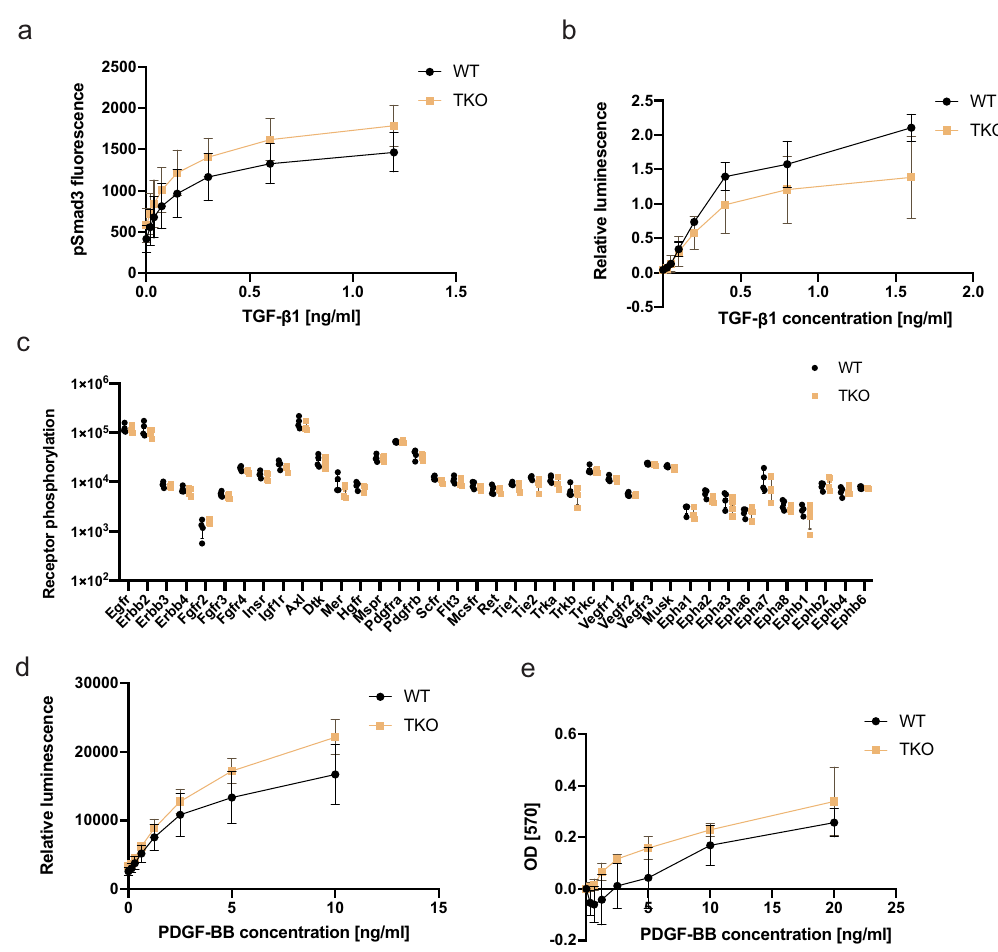
Fig. 5 TGF- β and RTK signaling appear unaltered in Lrig -null MEFs. a Wild-type (WT) and Lrig -null (TKO) MEFs were stimulated with various concentrations of TGF- β 1 for one hour and then analyzed for nuclear phospho-Smad3 (pSmad3) by an immunocyto fl uorescence assay. b Wild-type and Lrig -null MEFs were transiently transfected with the TGF- β reporter plasmid p(CAGA) 12 MLP-Luc followed by treatment of the cells with the indicated concentrations of TGF- β 1 for three hours. Cell lysates were then analyzed for luciferase activity. Shown is the relative luminescence on an arbitrary scale. c Wild-type and Lrig -null MEFs, cultivated under standard cell culture conditions in 10% FBS, were lysed and analyzed for RTK phosphorylation levels with a phospho-RTK array kit (R&D Systems). d Wild-type and Lrig -null MEFs stably expressing the MAPK reporter gene ELK1/SRF-luc were treated with different concentrations of PDGF-BB for four hours and then lysed and analyzed for luciferase activity. e Wild-type and Lrig -null MEFs were cultivated in FBS-free medium containing different amounts of PDGF-BB for 48 h. Thereafter, the relative cell numbers were determined using an MTT assay. Shown are the OD values of treated MEFs normalized to those of untreated MEFs. a , b , d and e The plotted values represent the means of four biological replicates, each with three experimental repeats. c The plotted values represent the means of four biological replicates, each with one experimental repeat. Error bars represent the standard deviations of the means from four biological also compared TGF- β and RTK signaling between wild-type and Lrig -null MEFs. TGF- β signaling was assessed using a TGF- β - responsive element-driven luciferase reporter, p(CAGA) 12 MLP- Luc , assay 42 or by analyzing the phosphorylation levels of Smad3 by fl uorescent immunocytochemistry. Neither of these analyses revealed any signi fi cant difference between wild-type and Lrig - null MEFs with regard to their TGF- β 1 responses (Fig. 5a, b). To investigate the role of Lrig proteins in steady-state RTK signaling levels in MEFs under standard cell culture conditions with 10% FBS, a phospho-RTK array was used. Surprisingly, there was no apparent difference in the speci fi c RTK phosphorylation levels between the wild-type and Lrig -null MEFs under the standard cell culture conditions employed (Fig. 5c). To further analyze the role of LRIG proteins in RTK signaling, a wild-type MEF line carrying fl oxed Lrig alleles was stably transduced with the MAPK reporter gene ELK1/SRF-luc . Thereafter, the stably transduced MAPK reporter MEFs were transduced with Cre recombinase or a